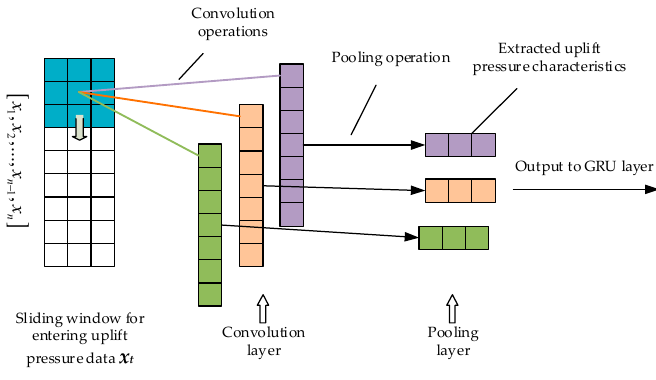
Figure 2. The CNN network structure.